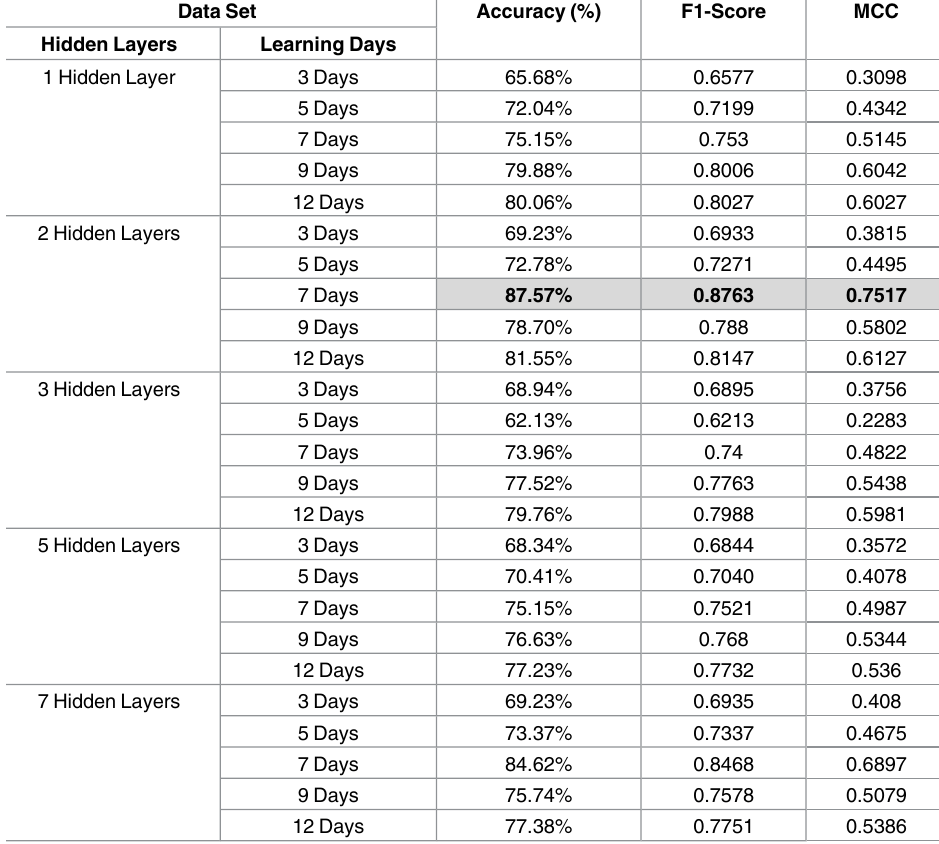
Table 5. Experimental results of predicted fluctuations in the EVE Online user population Data Set Accuracy (%) F1-Score MCC Hidden